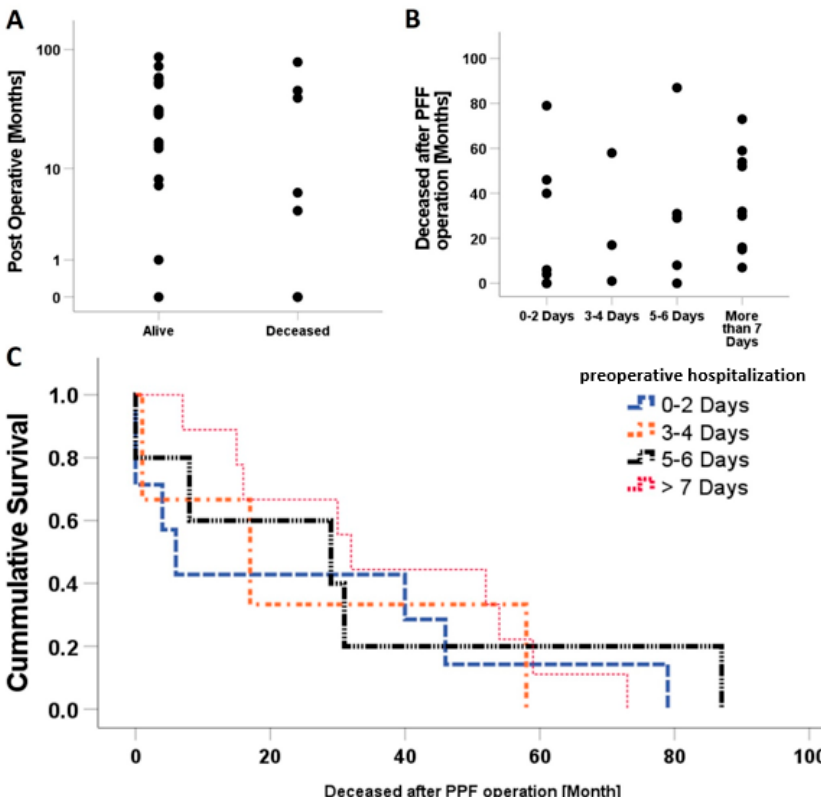
Figure 4. Correlation between mortality and time. ( A ) No statistically significant correlation between the numbers of patients survived or deceased after the operation. ( B ) Patient’s mortality was not affected by the duration of hospital stay pre-operatively. ( C ) Survival is not correlated to preoperative hospitalization days.